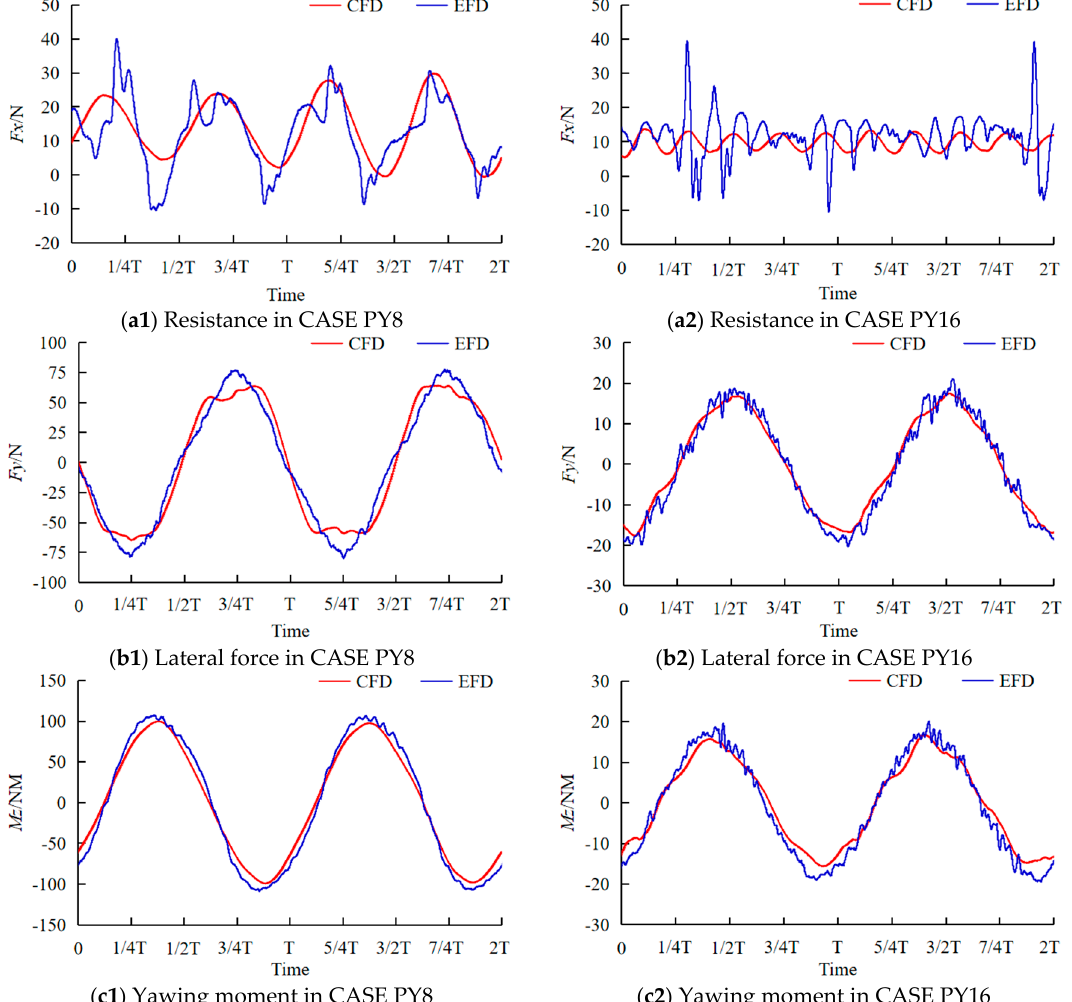
Figure 16. Forces and moment in CASE PY8 (left) and PY16 (right) (a: resistance; b: lateral force; c: yawing moment). Table 7. Comparison between the predicted and experimental forces and moment in pure yaw tests.